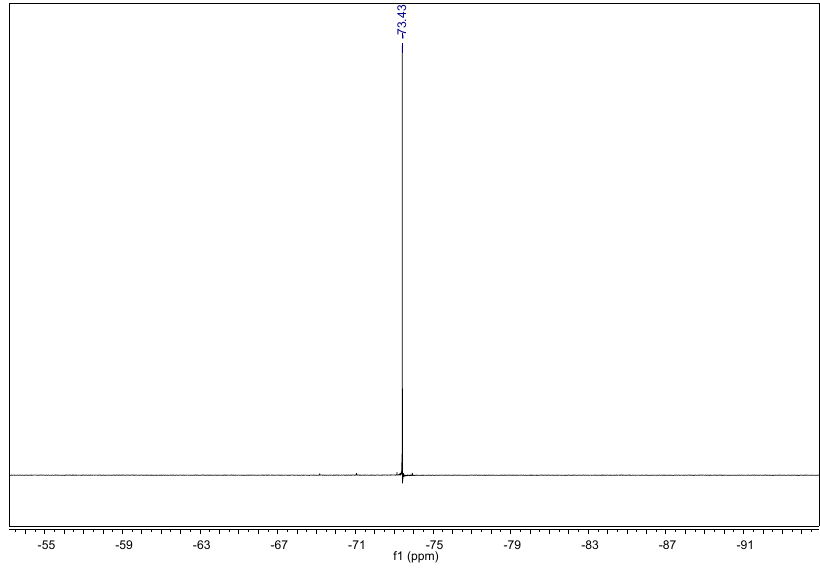
Figure 7. 19 F NMR spectrum of compound 2 6 .